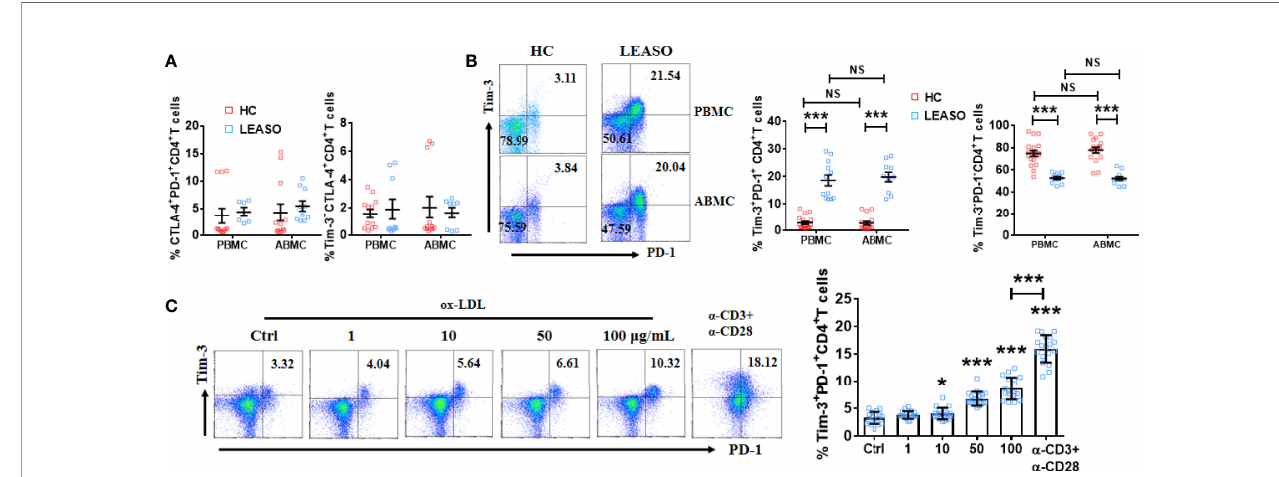
FIGURE 1 | Higher proportion of Tim-3 + PD-1 + CD4 + T cells in LEASO. (A) Frequency of CTLA-4 and PD-1 co-expression and Tim-3 and CTLA-4 co-expression on CD4 + T cells from the femoral artery blood of the affected limb [arterial blood mononuclear cells (ABMCs)] and peripheral venous blood (peripheral blood mononuclear cells (PBMCs)] of LEASO patients and HCs, n=6-12. (B) The percentage of Tim-3 + PD-1 + CD4 + T cells and Tim-3 - PD-1 - CD4 + T cells in the circulation of LEASO patients and HCs, n=10 – 18. (C) Quanti fi cation of fl ow cytometric analysis of Tim-3 and PD-1 co-expression on peripheral CD4 + T cells of HCs treated with the indicated concentrations of ox-LDL for 48 h. The a -CD3 and/or a -CD28 antibodies were used in some wells. n=18, Data represent mean ± standard error of the mean (SEM). *P < 0.05, ***P < 0.001, NS, no signi fi cance,